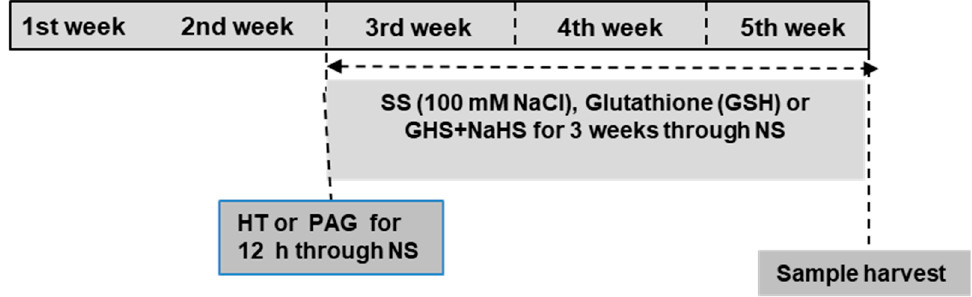
Figure 1. A scheme of the treatments used to study the e ff ect of salinity stress (SS, 100 mmol L − 1 NaCl) in sweet pepper plants. The concentrations used of each chemical were glutathione (1.0 mmol L − 1 GSH) or sodium hydrosulfide (0.2 mmol L − 1 NaHS) alone or combined with scavenger of H 2 S, hypotaurine (0.1 mmol L − 1 HT), or inhibitor of l -DES, dl -propargylglycine (0.3 mmol L − 1 PAG).